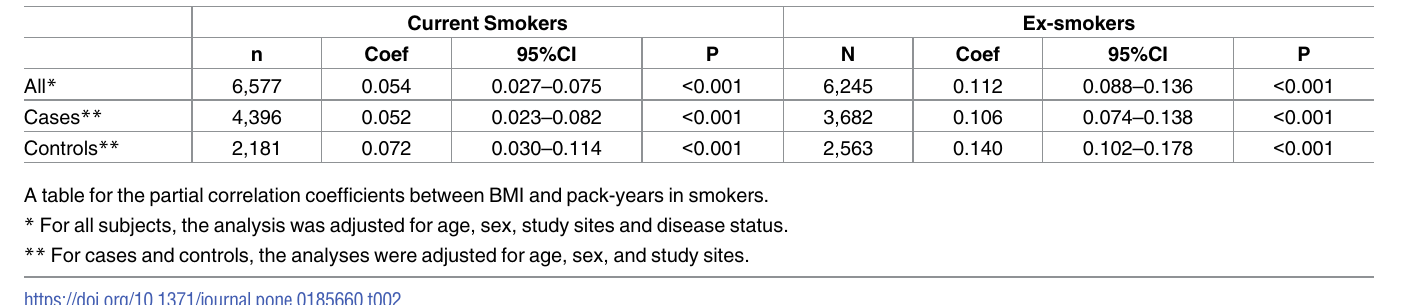
Table 2. Partial correlations between BMI and pack-years of smoking by smoking status.